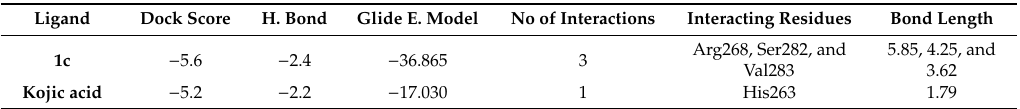
Table 3. Molecular docking interactions of compound 1c and control kojic acid against mushroom Table 2.